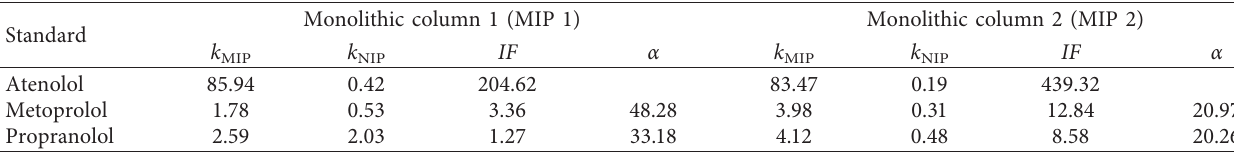
Table 9: Selectivity of the imprinted monolithic